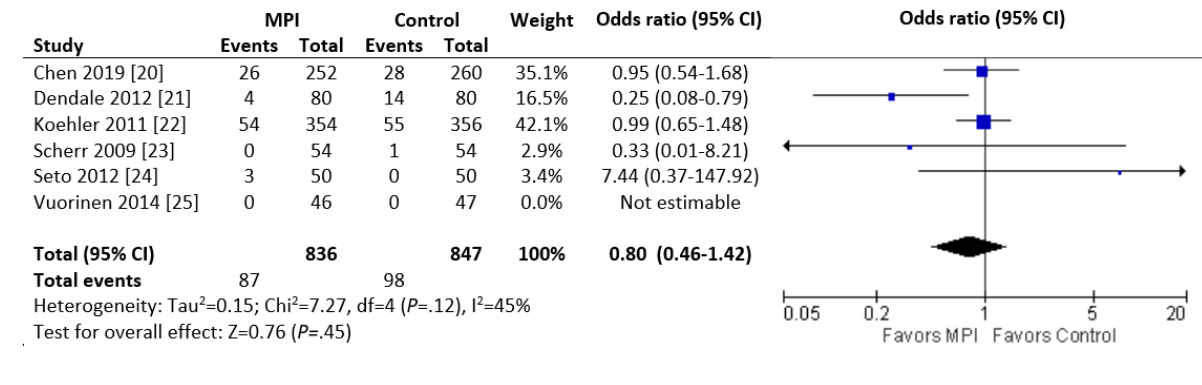
Figure 2. Forest plot of the odds ratio (OR) of mortality in patients with heart failure who were involved in randomized controlled trials comparing a mobile phone intervention versus control. The estimate of the OR of each trial corresponds to the middle of the squares, and the horizontal line shows the 95% CI. The summary OR is represented by the middle of the solid diamond. A test of heterogeneity is given below the summary statistics. MPI: mobile phone intervention, df: degrees of freedom.